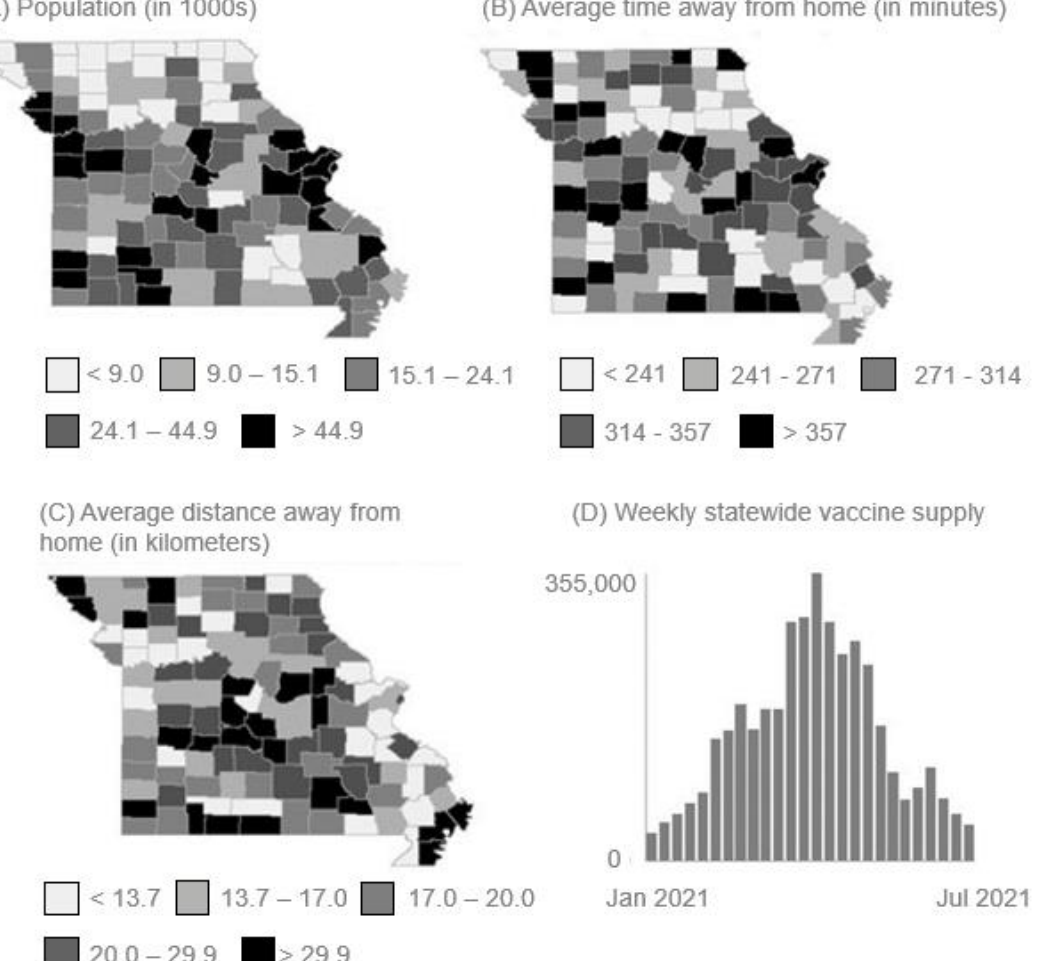
Figure 1. Descriptive quantile maps of ( A ) Missouri county populations (as of 2019), ( B ) average visit time (minutes) spent at a location outside the home (Jan 2021–July 2021), ( C ) average distance (kilometers) residents traveled to visit a location outside the home (Jan 2021–July 20201), ( D ) weekly number of COVID-19 vaccines distributed among Missouri counties (Jan 2021–July 2021). Table 1. Fixed effect estimates predicting weekly COVID-19 cases across Missouri Counties from January 2021 to July